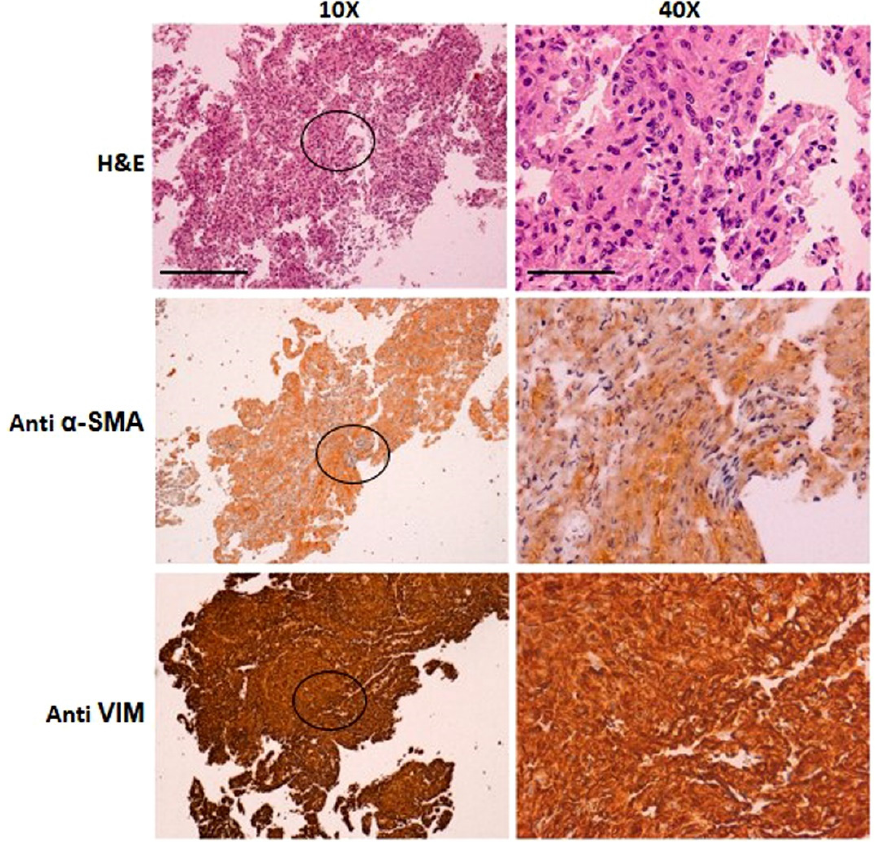
Figure 5. Immunocytochemical characterization of cytocentrifuged samples of SCI13D cells with hematoxylin–eosin (H&E), anti- α -smooth muscle actin (Anti α -SMA), and anti-vimentin (Anti VIM) staining of SCI13D cells; areas indicated in the 10 × images (left column; scale bar = 25 µ m) are enlarged (40 × ; scale bar = 6.25 µ m) in the right column.